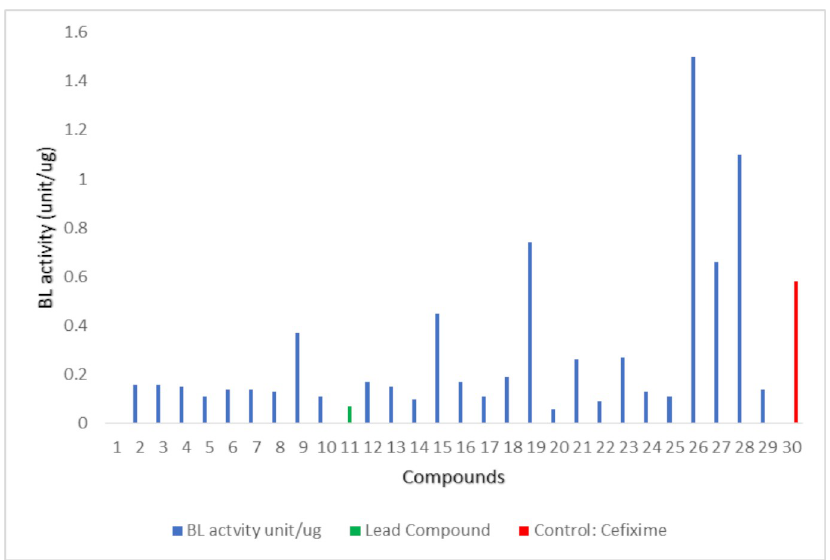
Fig 9. BL activity of further screened compounds with negative control (Chembridge ID: 5524250) in green color and positive control in red color.